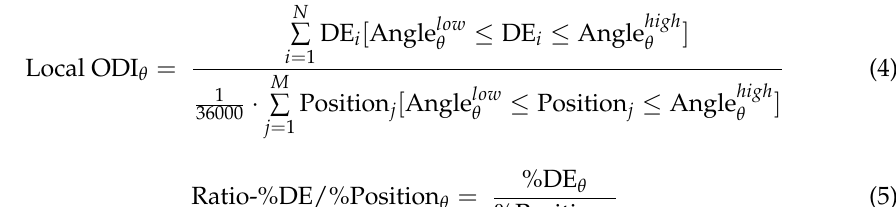
Figure 3. Screenshots of the ‘SleepPos’ app. The ‘Acquisition’ tab ( a ) is used to record the sleep position. Upon clicking the ‘Start’ button, a dialog is prompted ( b ) asking if positional treatment should be applied. Afterwards, the sleep position is acquired and displayed ( c ) on the polar plots as well as the accelerometry values and the time spent on the acquisition. The ‘Recordings’ tab ( d ) shows the details of each acquisition, which include the date, hour of start, and duration. The ‘Re- sults’ tab ( e ) shows a summary of the sleep position for each acquisition. When clicking over each summary, a window prompts ( f ) showing the sleep position with angular resolution, as well as a table with the summarized details of the